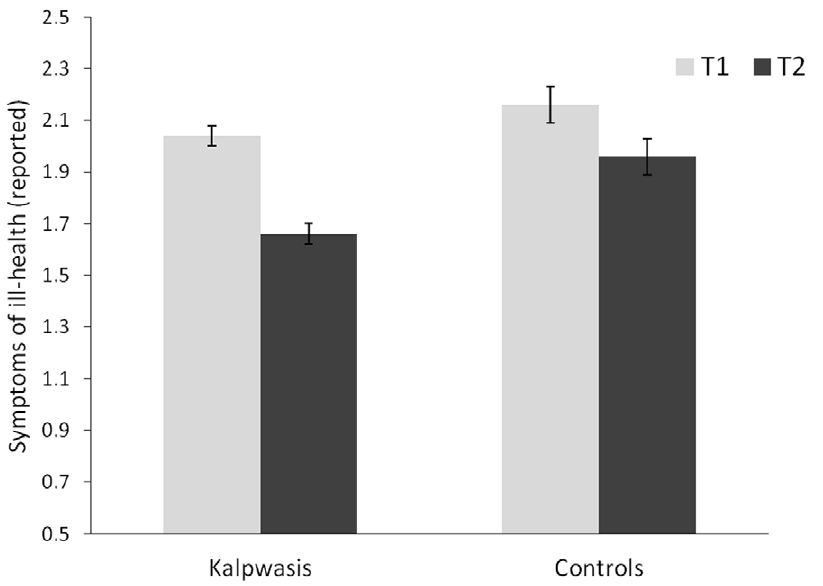
Figure 3. Symptoms of Ill-health amongst Kalpwasis and Controls at T1 and T2. Estimated Marginal Means and Standard Errors.